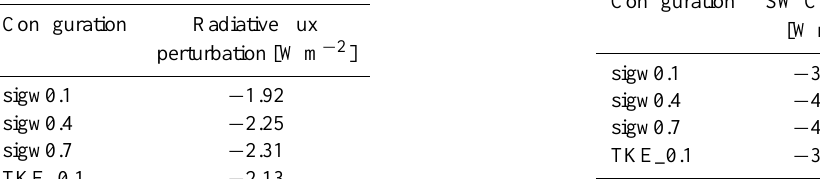
Table 7. Global mean shortwave cloud radiative effect (SW CRE) for each model configuration.